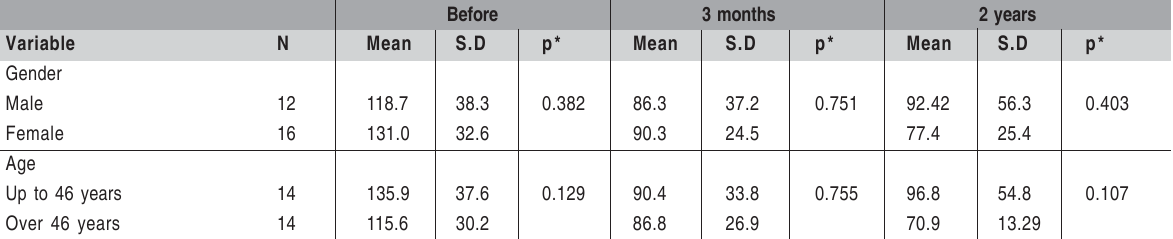
Table 2. OHIP values in relation to gender (female/male) and age (up to 46 years/over 46 years).